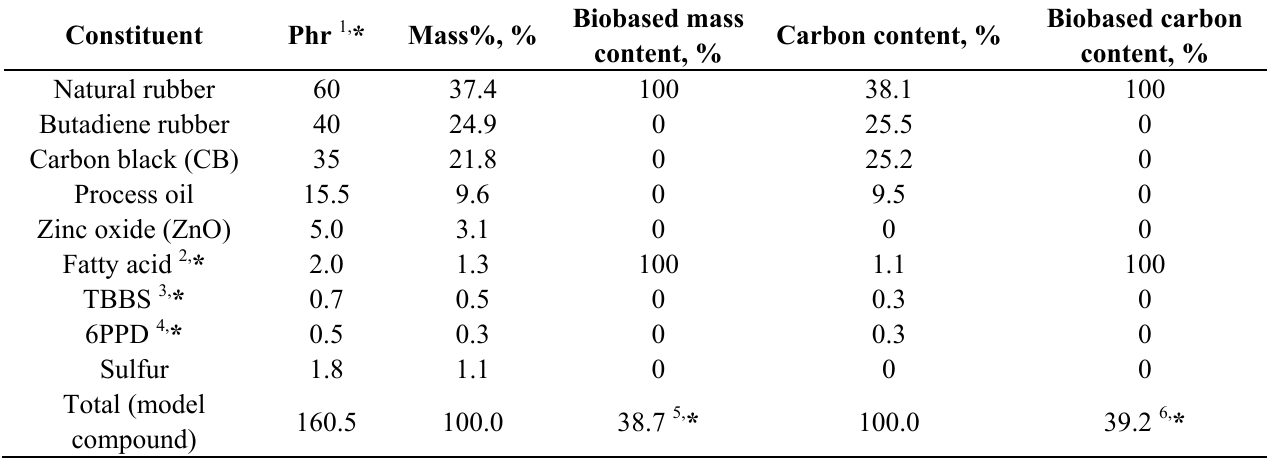
Table 5. Recipe of natural rubber model compound.